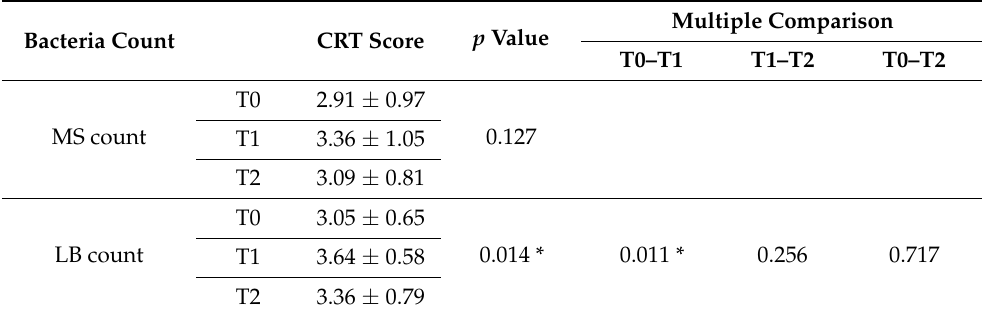
Table 4. CRT score of the high-caries-risk group among three time